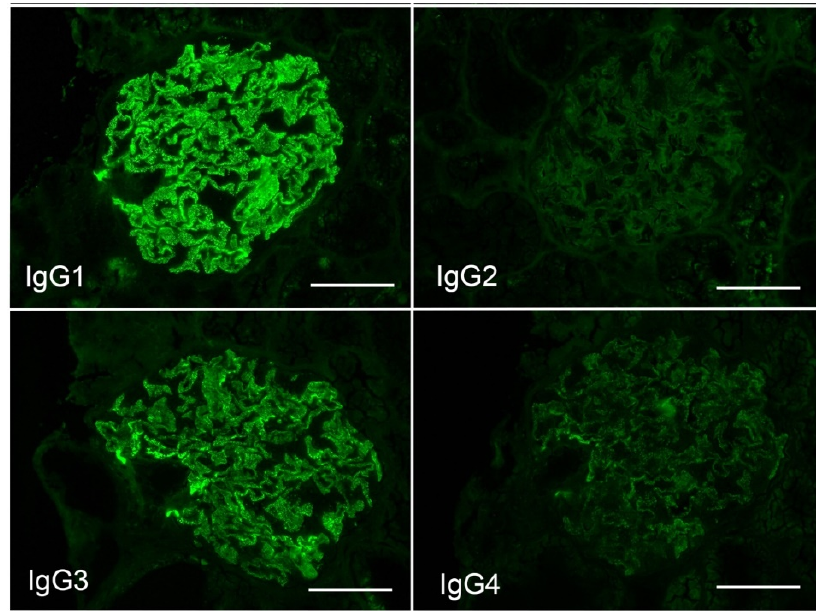
Figure 2. Immunofluorescence of IgG subclass staining. The bars indicate 50 µ